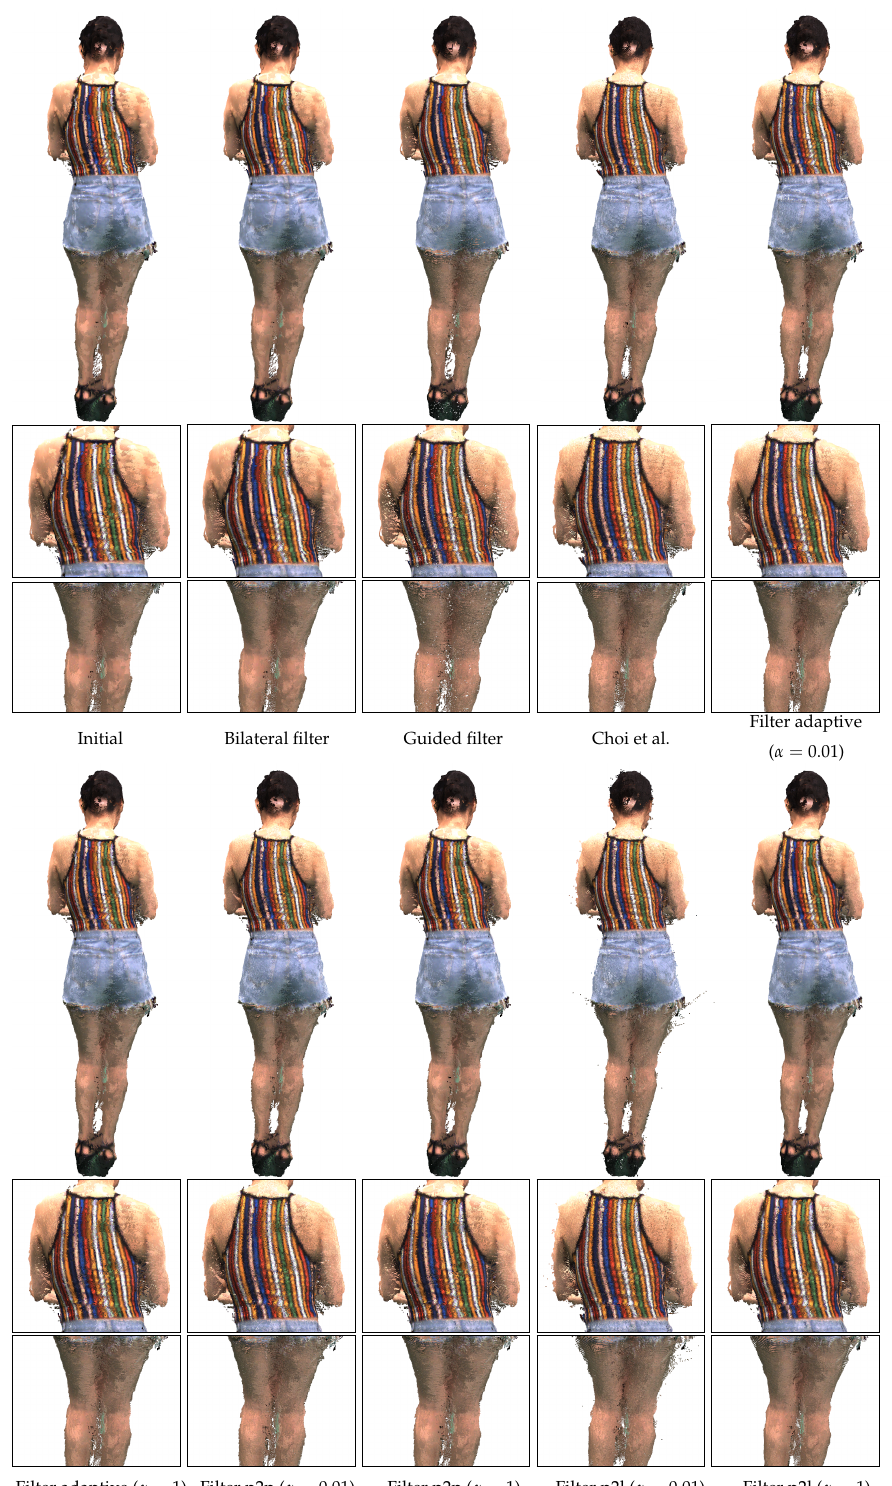
Figure 7. Point cloud rendering results. ( First and fourth rows ): Merged point clouds. ( Second, third, fifth and sixth rows ): Magnified regions. We note that neither a preprocessing nor a postpro- cessing method has been applied to the